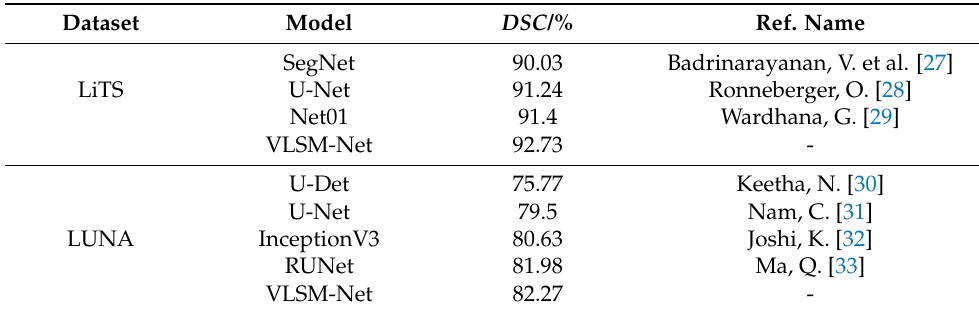
Table 3. Comparison of models in LiTS17 and